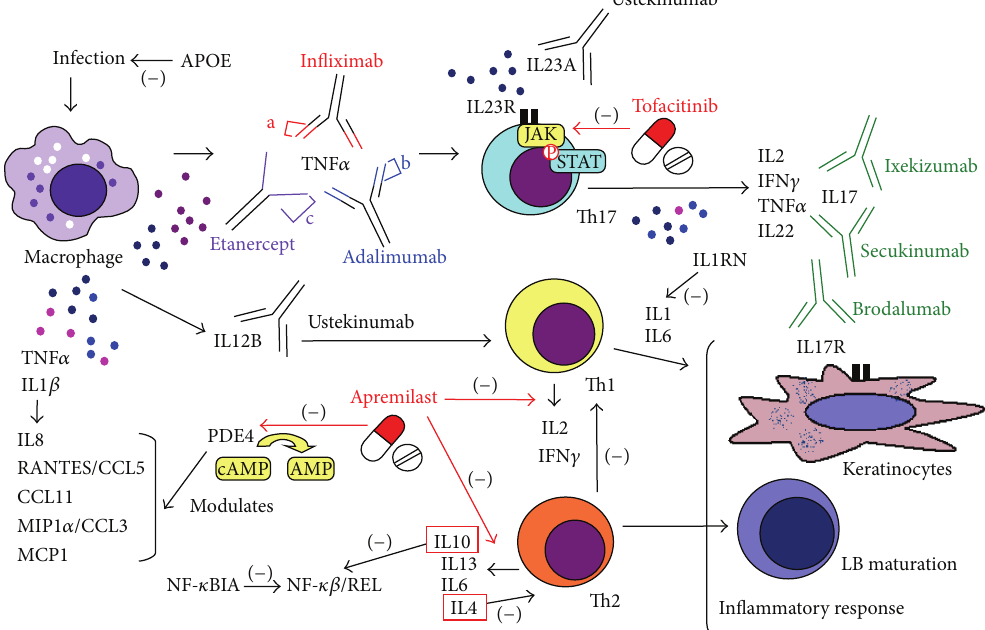
Figure 1: Simplified representation of the main mediators of inflammation in psoriasis, the therapeutic targets of biological drugs, and oral alternatives currently under development. Th: helper T lymphocyte; LB: lymphocyte B; APOE: apolipoprotein E; TNF: tumor necrosis factor; IL: interleukin; RANTES, chemokine regulated on activation normal T cells expressed and secreted; CCL: chemokine Cys-Cys motif ligand; MIP: macrophage inflammatory protein; MCP: monocyte chemoattractant protein; PDE4: phosphodiesterase 4; cAMP: cyclic adenosine monophosphate; IFN: interferon; JAK: Janus kinase; STAT: signal transducer and activator of transcription; NF- 𝜅 BIA: nuclear factor of kappa lightpolypeptidegeneenhancerinBcellsinhibitor;NF- 𝜅 B/REL:nuclearfactorkappaB/v-relreticuloendotheliosisviraloncogenecomplex;a: infliximab, mouse variable region; b: adalimumab, human variable region; c: etanercept, Human TNRFp75 (TNRF2); ( − ) indicates inhibition and ( → ) indicates